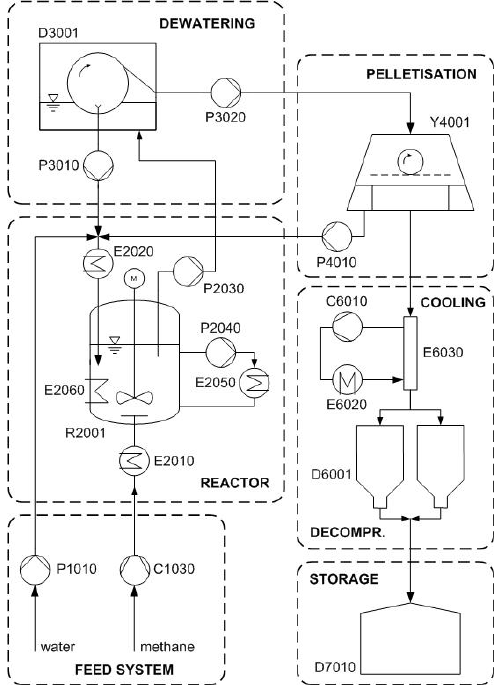
Figure 4. Conceptual flow diagram for the methane hydrate production and pelletisation